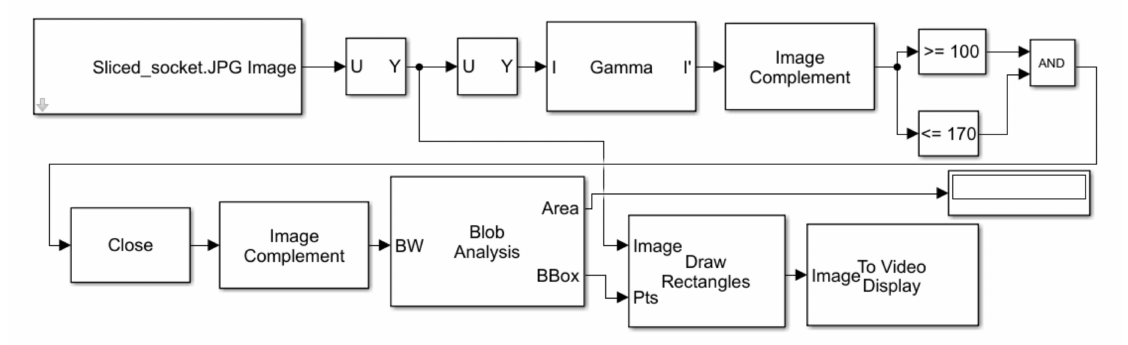
Figure 8. Simulink block diagram to generate total pixel on the